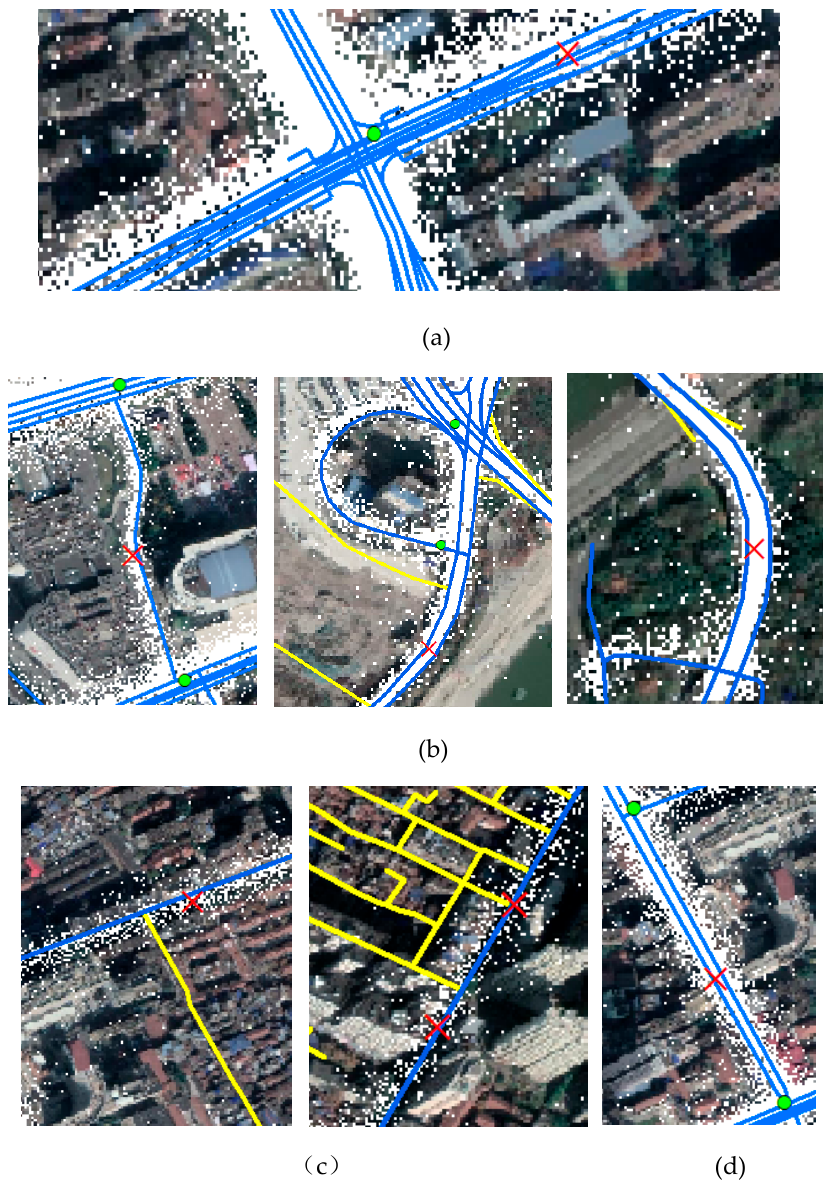
Figure 20. The situation of incorrectly identifying road intersections (the blue line is the urban traffic